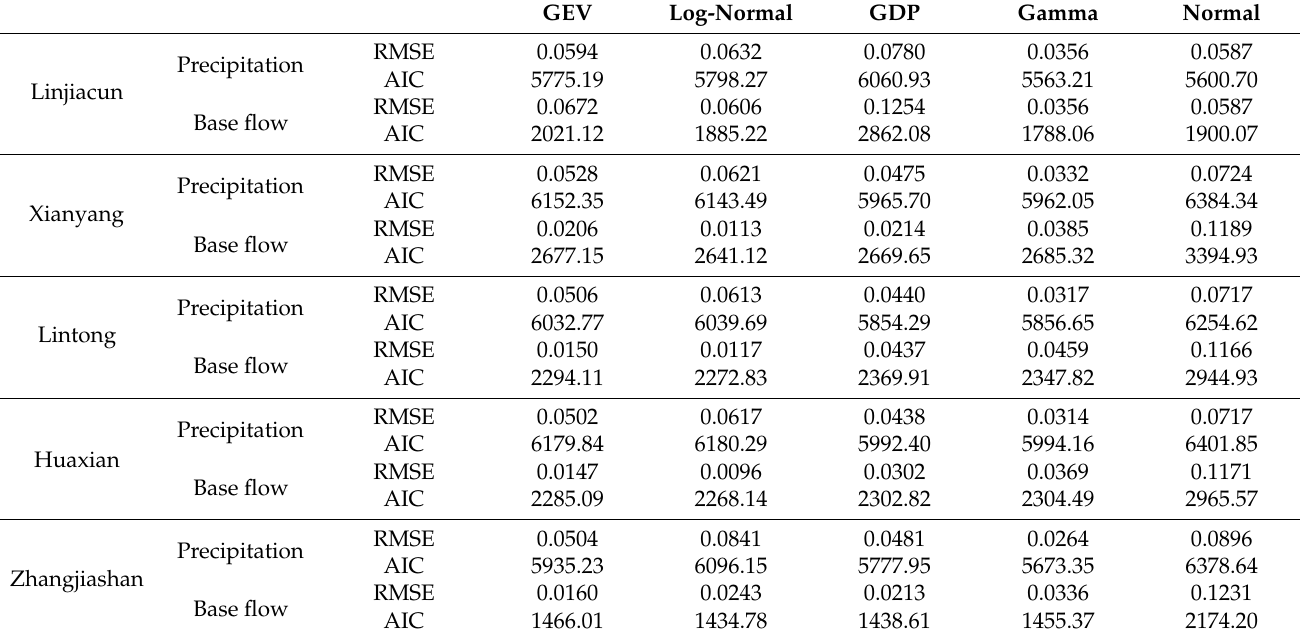
Table 4. Precipitation and base flow edge distribution model fitting excellence test results.